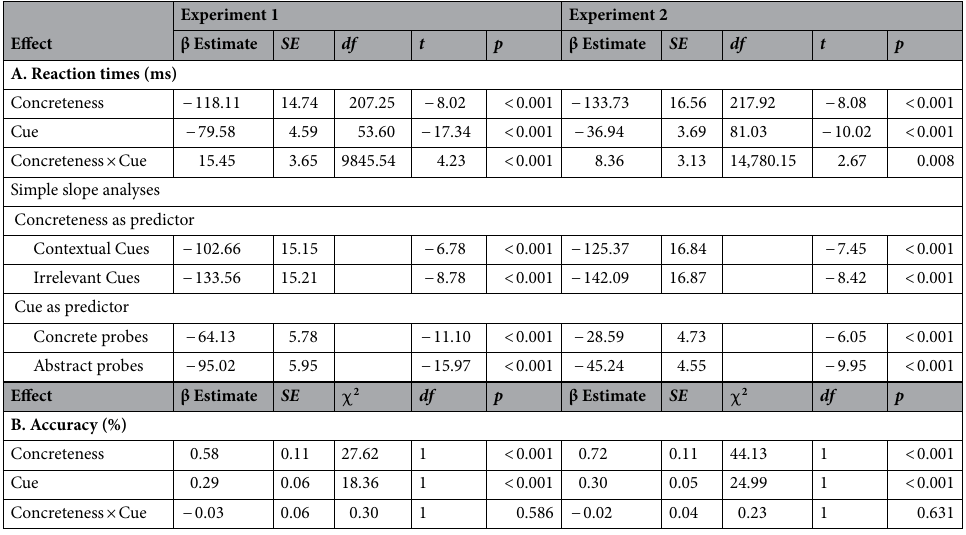
Table 3. Βeta estimates and their standard error, estimated degrees of freedom, t-/ χ 2 and p -values for (G) LME analyses with the factors Concreteness and Cue on single-trial reaction times (A) and accuracy (B) in the synonym judgment task in Experiment 1 and 2. Simple slope analyses with Concreteness as predictor investigated the effect of Concreteness within the relevant/irrelevant cue condition. Simple slope analyses with Cue as predictor investigated the effect of Cue within the concrete/abstract condition. SE standard error, df degrees of